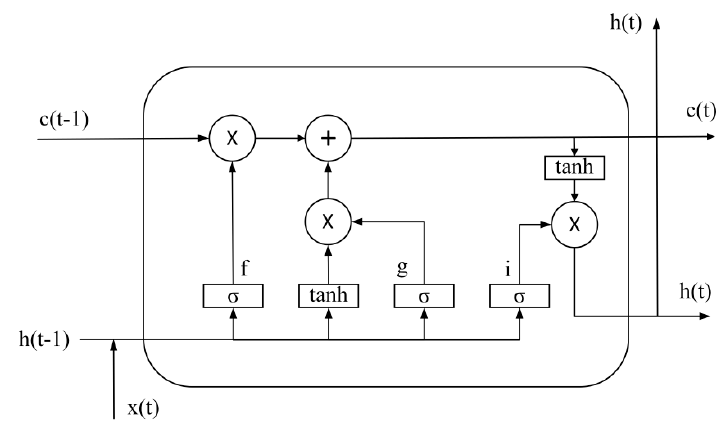
Figure 1. One-way Bi-LSTM structure diagram. Figure 1. One‑way Bi‑LSTM structure